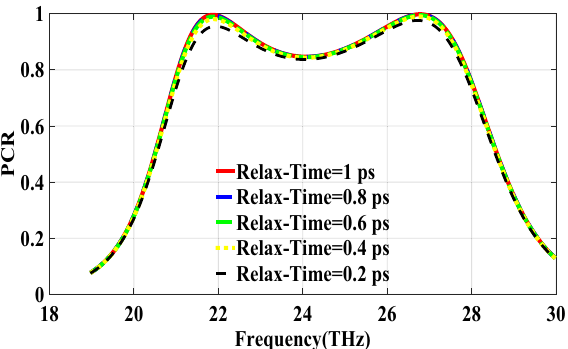
Figure 25. PCR of the fourth structure for different relaxation times of